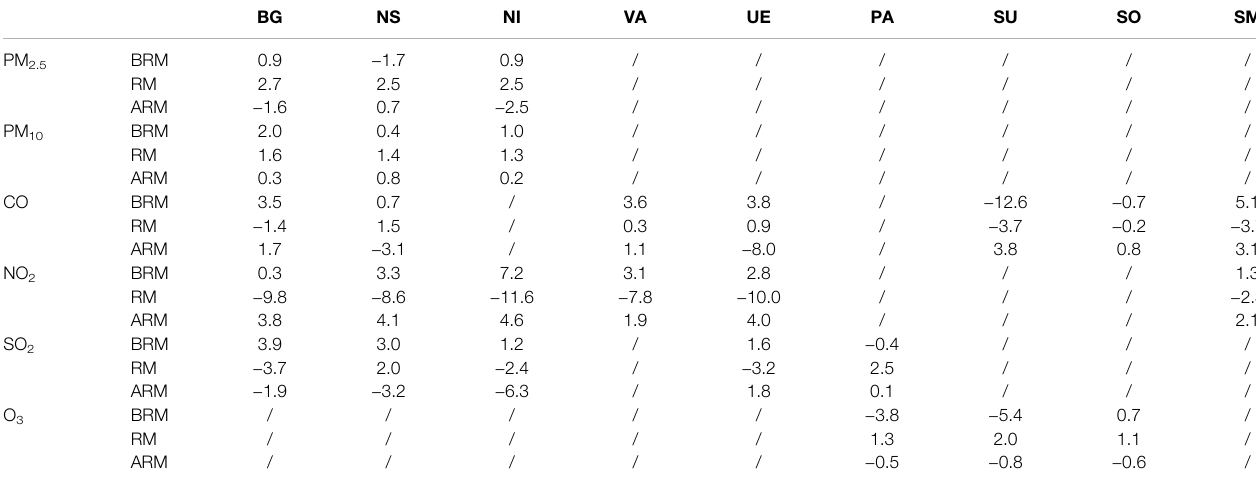
TABLE 1 | Differences between measured and “ deweathered ” mean concentrations were shown as percentages (%) before (BRM), during (RM), and after the restrictive measures (ARM). ‘ / ’ means that there is no measurement of a speci fi c air pollutant at this particular